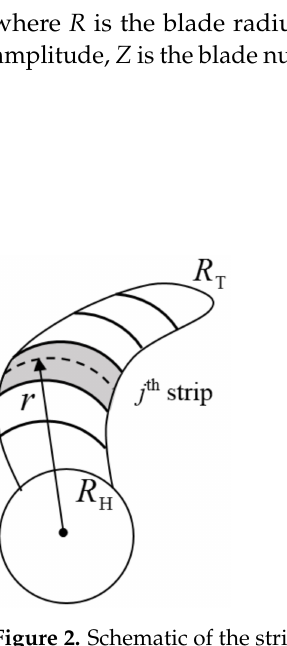
Figure 2. Schematic of the strip method.